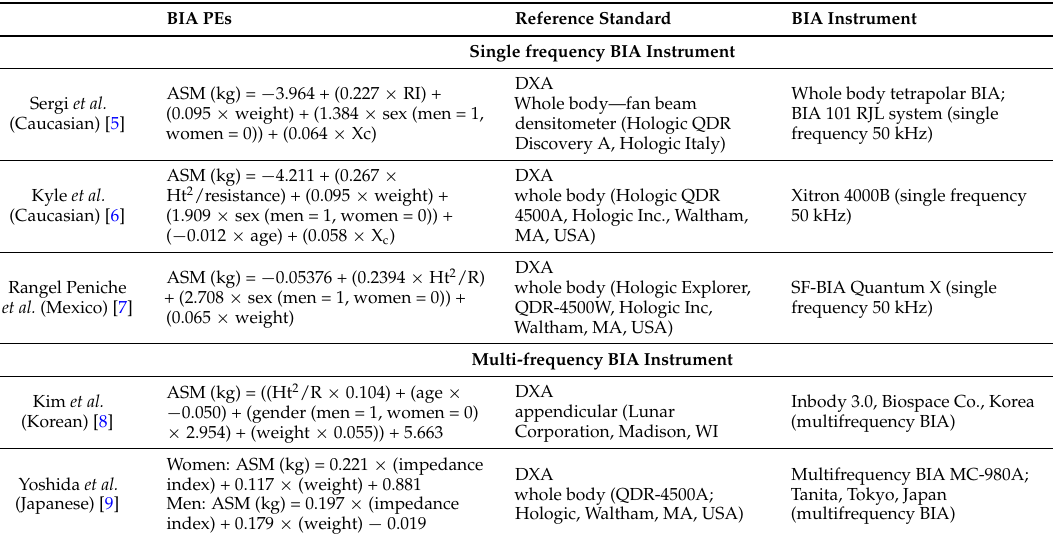
Table 1. Developed and validated bioelectrical impedance prediction equations used in estimation of appendicular skeletal muscle